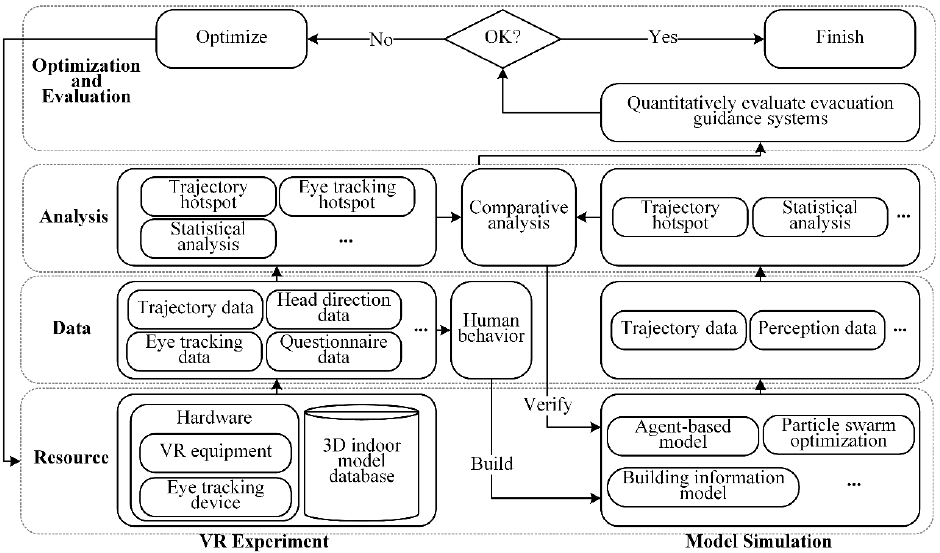
Figure 1. Framework for optimizing and evaluating evacuation guidance systems.